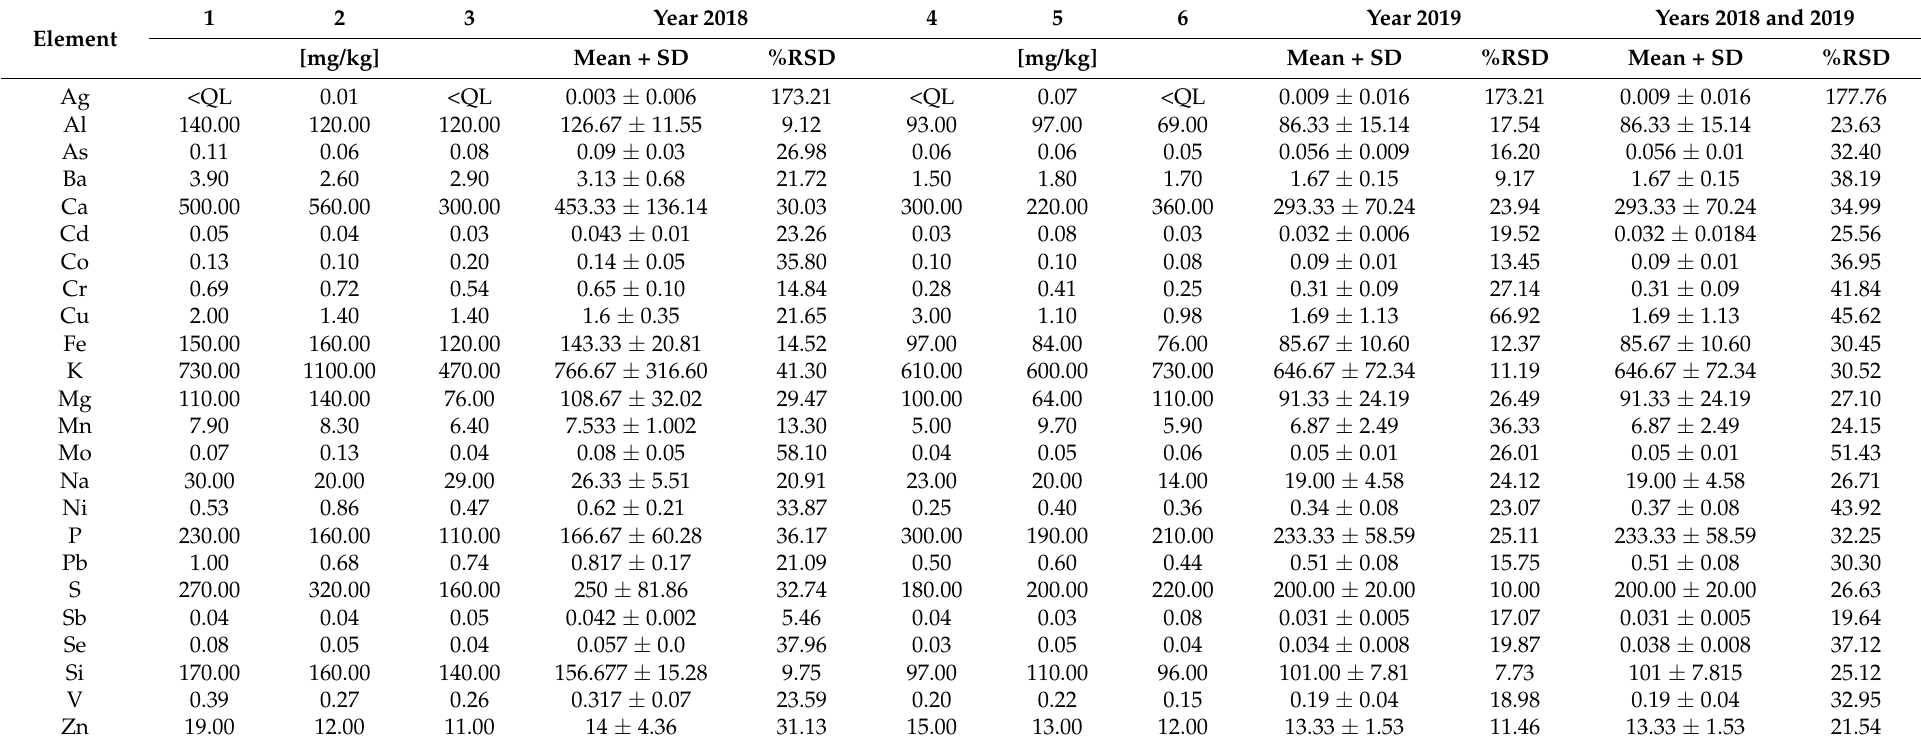
Table 2. Levels of 24 selected elements measured in propolis along with mean, standard deviations (SD), and relative standard deviation (%RSD) values, calculated for each year separately and all samples in total; 1, 2, 3—samples collected in 19 May, 23 June and 8 July 2018, respectively; 4, 5, 6—samples collected in 19 May, 1 June and 29 June 2019, respectively. Values of mean and SD are expressed in mg/kg, QL—quantification